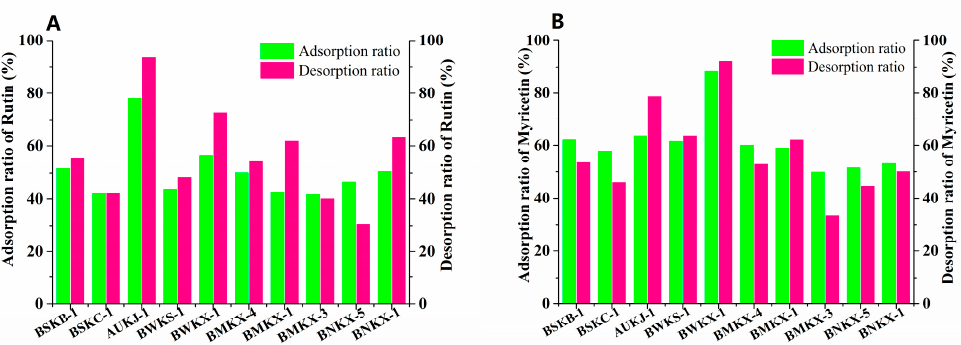
Figure 1. Adsorption/desorption ratios for rutin ( A ) and myricetin ( B ) on ten resins.